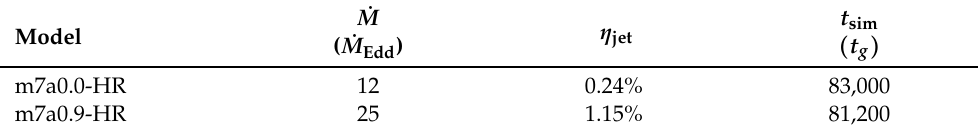
Table 1. We tabulate the mass accretion rate ˙ M , jet efficiency η jet ≡ L jet / ˙ Mc 2 (where L jet is the jet power as defined in [14]), and total simulation duration t sim for each KORAL simulation. Note that ˙ M and η jet are time averaged over the final 50,000 t g of each simulation. ˙ M t sim η jet Model ( ˙ M Edd ) ( t g ) m7a0.0-HR 12 0.24% 83,000 m7a0.9-HR 25 1.15%